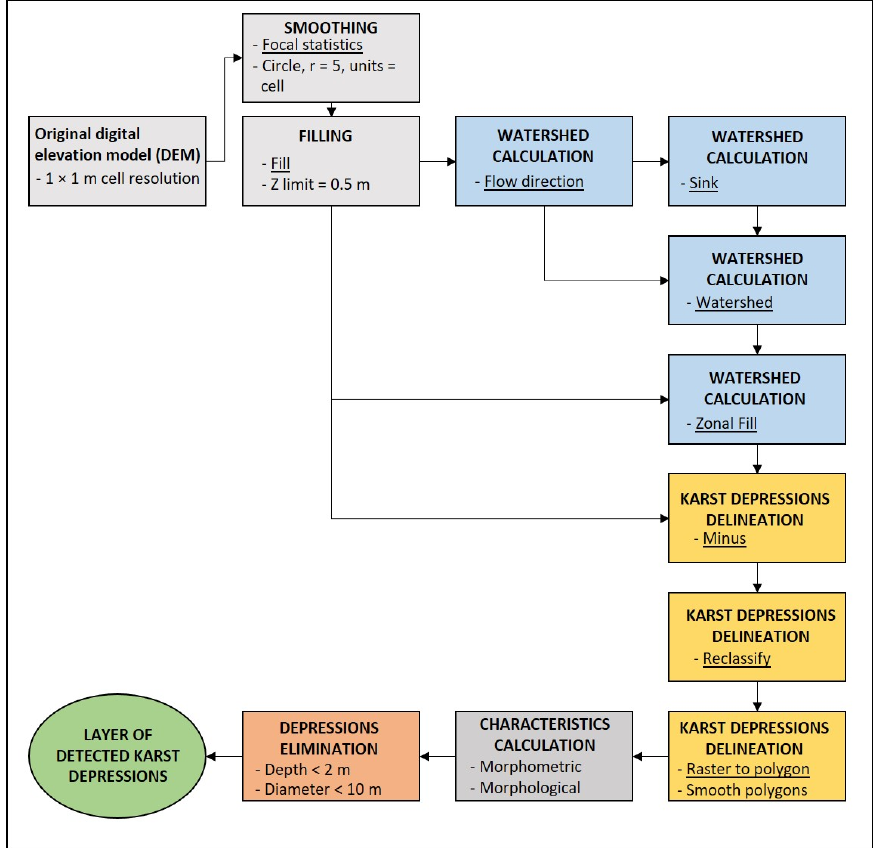
Figure 2. Flowchart of karst depressions detection.